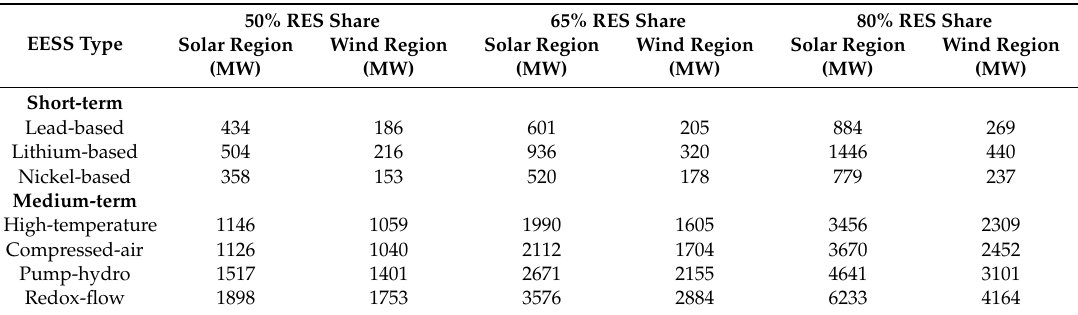
Table A10. Resulting installed electrical storage demand.